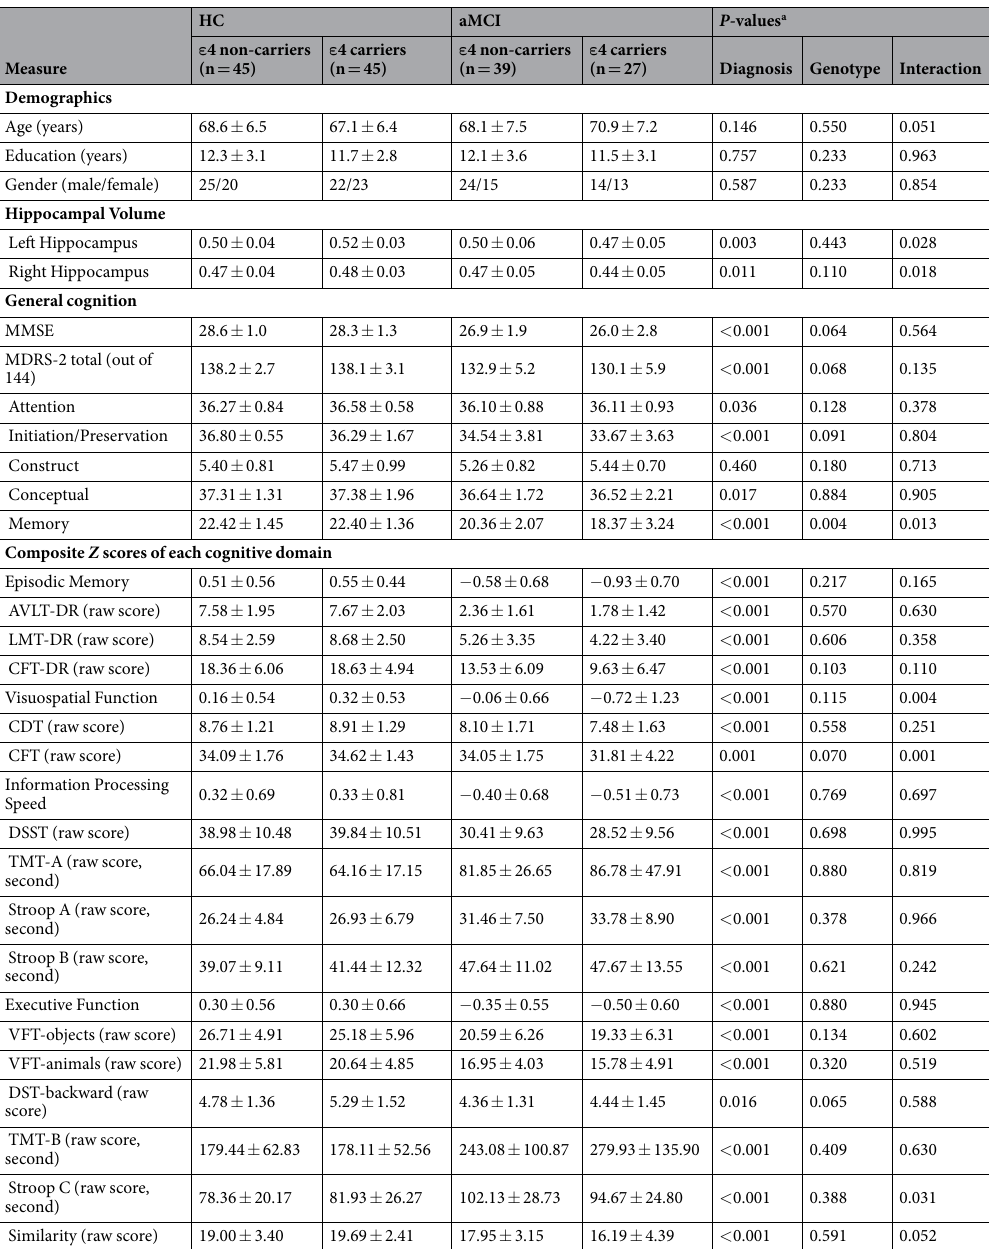
Table 1. Demographic and neuropsychological data for all participants. Data are presented as the mean ± standard deviation (SD). a P -values were obtained by two-way analysis of covariance (ANCOVA). The performance of each neuropsychological test is expressed as raw scores. The level of each cognitive domain is denoted by the composite Z scores. “ ε 4 carriers” denotes the subjects who possessed at least one APOE ε 4 allele; “ ε 4 non-carriers” denotes the subjects who possessed homozygous for the APOE ε 3 allele. Abbreviations: aMCI, amnestic mild cognitive impairment; HC, healthy control; MMSE, mini-mental state examination; MDRS-2, Mattis dementia rating scale-2; AVLT-DR, auditory verbal learning test-20 min delayed recall; LMT-DR, logical memory test-20 min delayed recall; CFT-DR, Rey-Osterrieth complex figure test-20 min delayed recall; CDT, clock drawing test; CFT, Rey-Osterrieth complex figure test; DSST, digital symbol substitution test; TMT-A, trail making test-A; Stroop, Stroop color test; VFT, verbal fluency test; DST, digit span test; TMT-B, trail making test-B; Similarity, semantic similarity